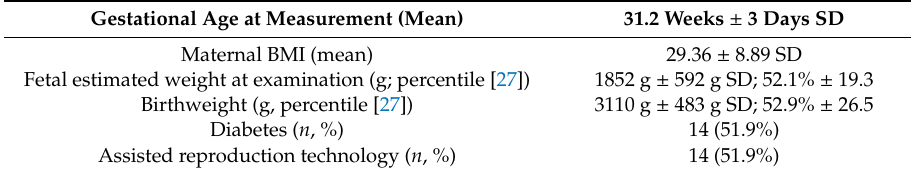
Table 1. Maternal and foetal characteristics.